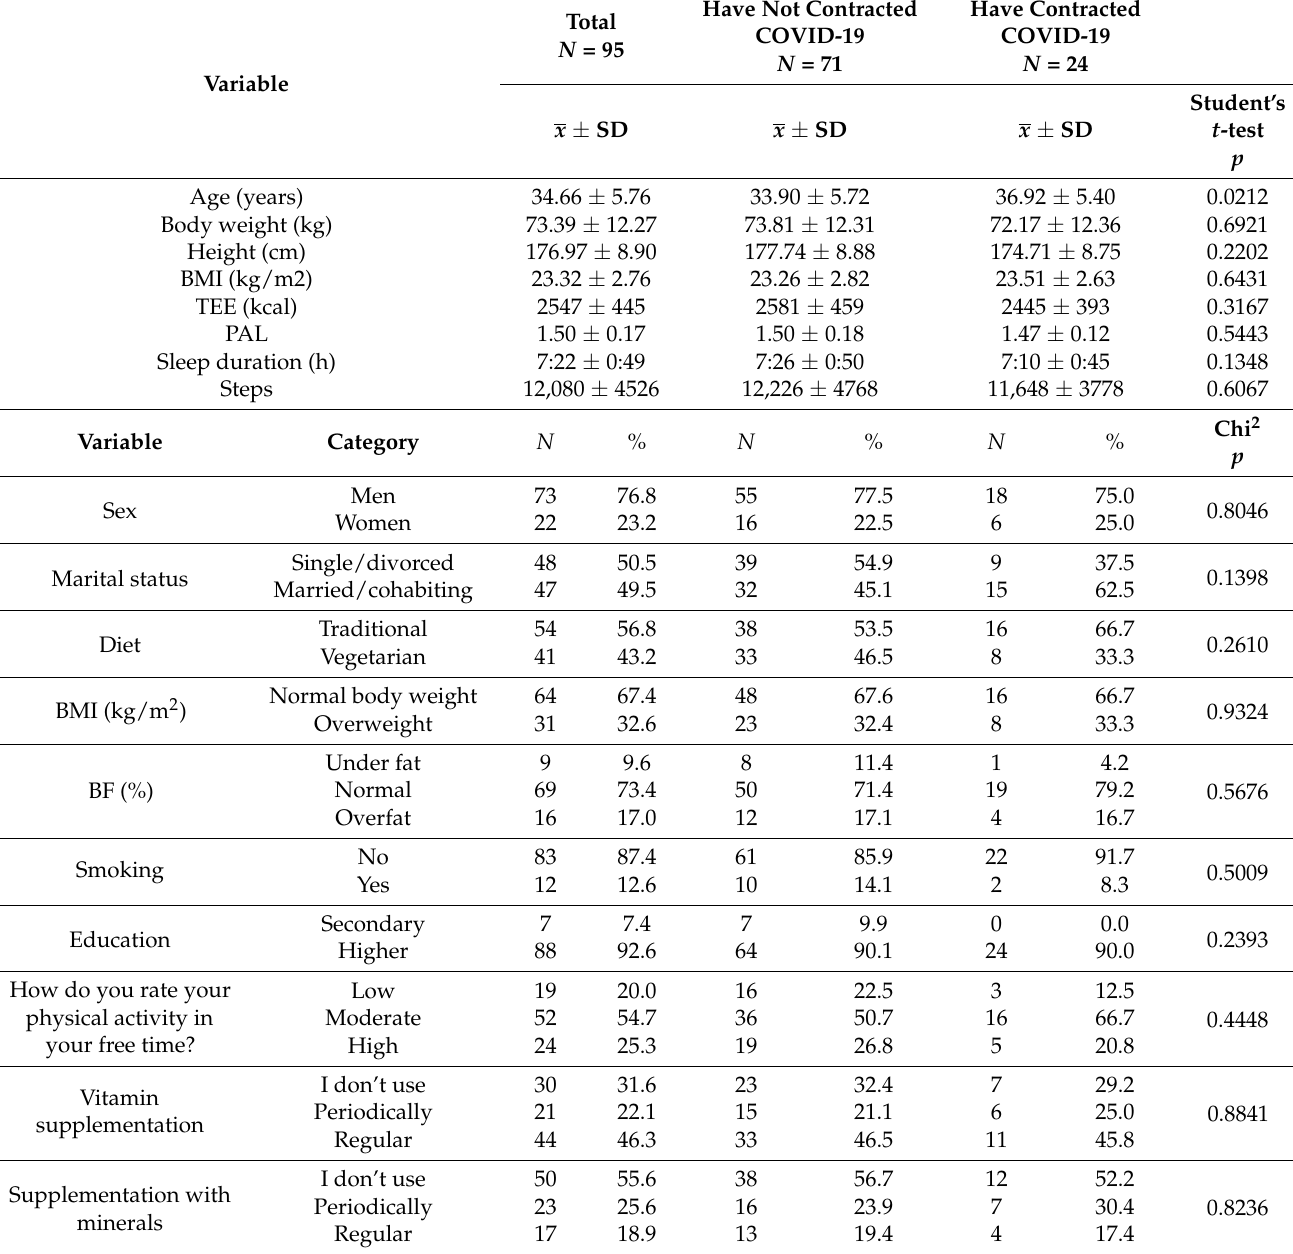
Table 1. Anthropometric and sociodemographic characteristics of the study